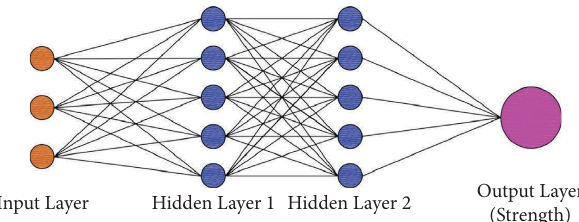
Figure 2: Neural network diagram.